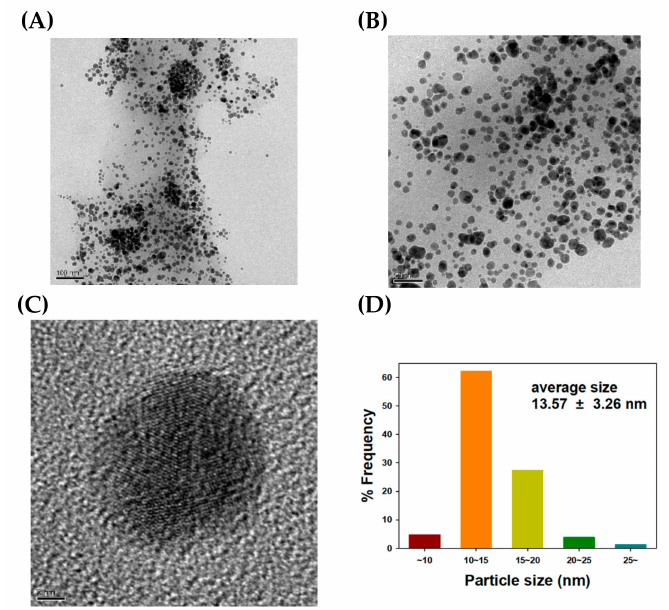
Figure 4. Field emission transmission electron microscopy (FE-TEM) images and a size histogram of TF-AgNPs. The scale bar represents ( A ) 100 nm, ( B ) 50 nm, and ( C ) 2 nm. ( D ) A size histogram was determined from the measurement of 207 discrete nanoparticles in FE-TEM images using the Image J